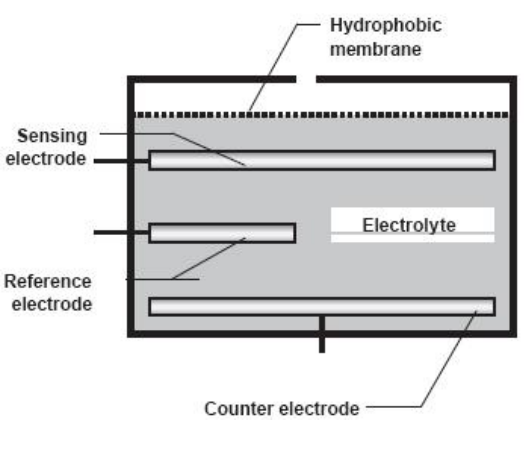
Figure 4. Detection scheme of an electrochemical